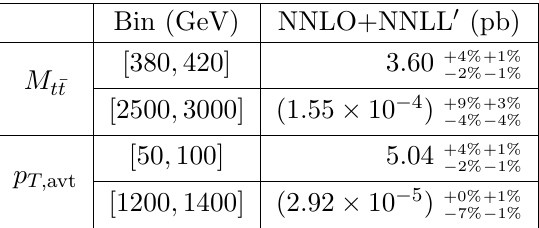
ated by varying each of the matching scales. In most instances, the dominant contribution to the uncertainty arises from the variation of (cid:22) the uncertainty from the matching scales is larger than at low M spectrum this source of uncertainty remains